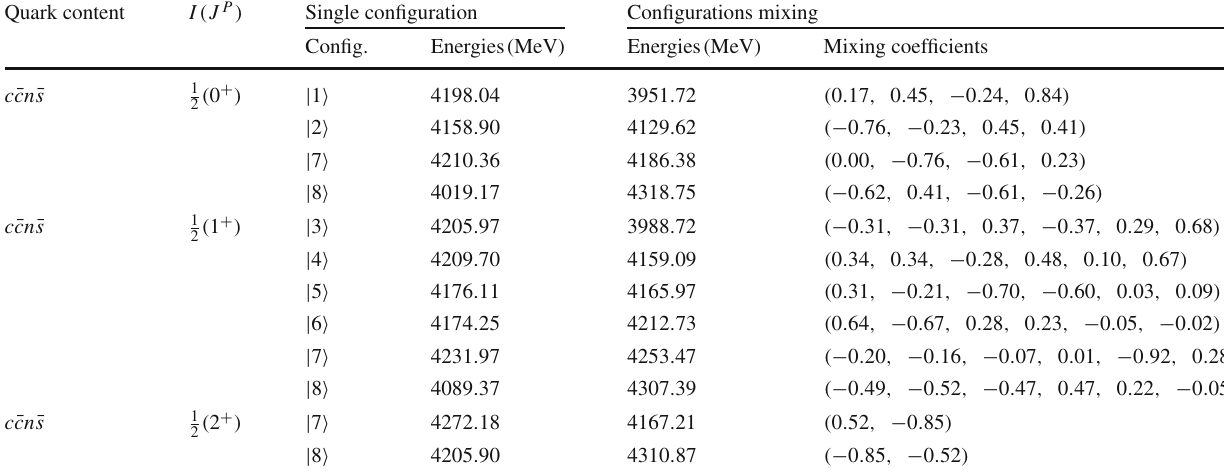
Table 10 As in Table 7 but for the case of Z cs states Quark content Single configuration Configurations mixing